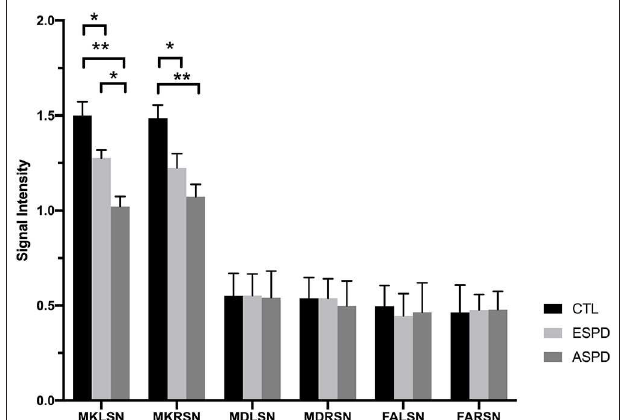
FIGURE 2 | Diffusion kurtosis imaging values in the substantia nigra for the control, early-stage Parkinson’s disease, and advanced-stage Parkinson’s disease groups. ASPD, advanced-stage Parkinson’s disease; CTL, control; ESPD, early-stage Parkinson’s disease; FALSN, fractional anisotropy of the left substantia nigra; FARSN, fractional anisotropy of the right substantia nigra; MDLSN, mean diffusivity of the left substantia nigra; MDRSN, mean diffusivity of the right substantia nigra; MKLSN, mean kurtosis of the left substantia nigra; MKRSN, mean kurtosis of the right substantia nigra. ** p < 0.01, ASPD vs. CTL; * p < 0.05, early-stage PD vs. CTL or advanced-stage PD vs. CTL or advanced-stage PD vs. early-stage PD.